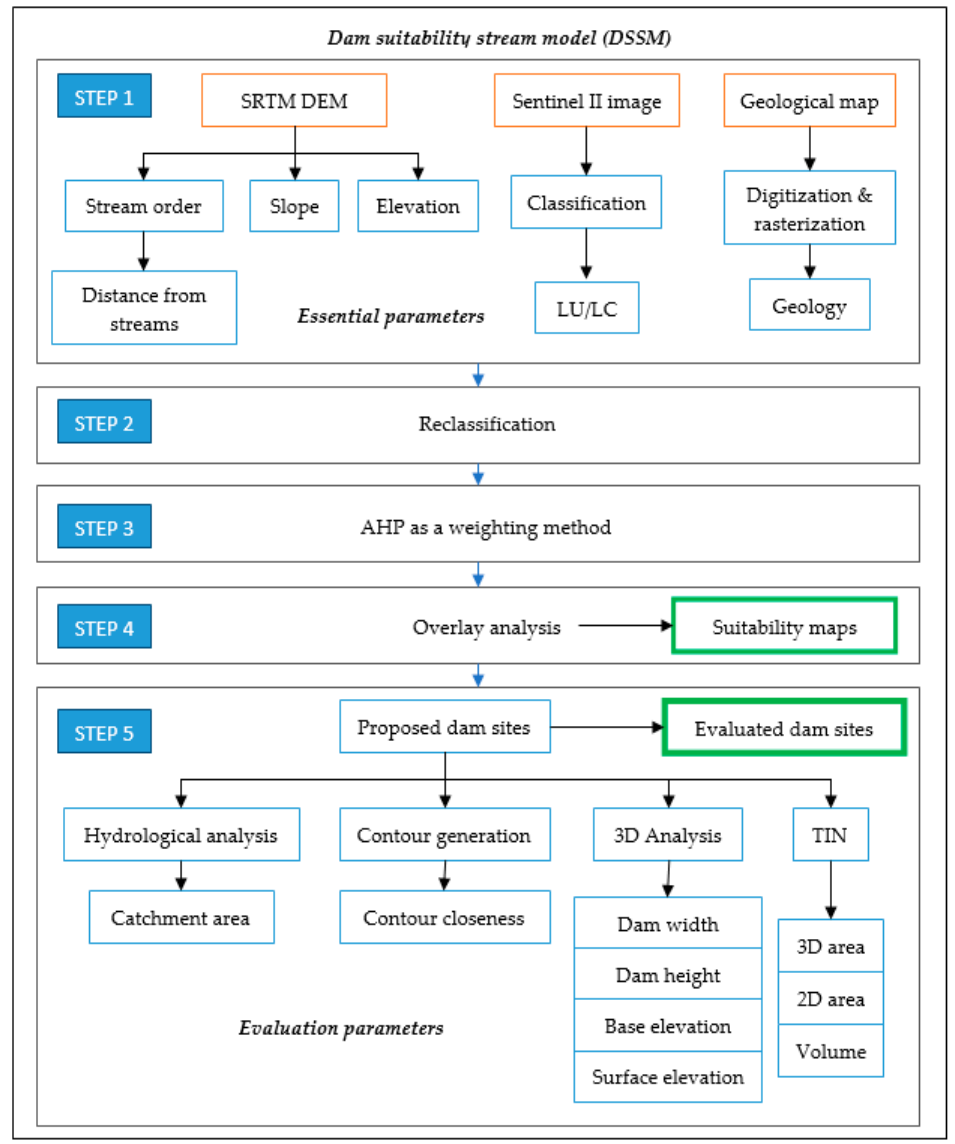
Figure 2. Work flow of this study.